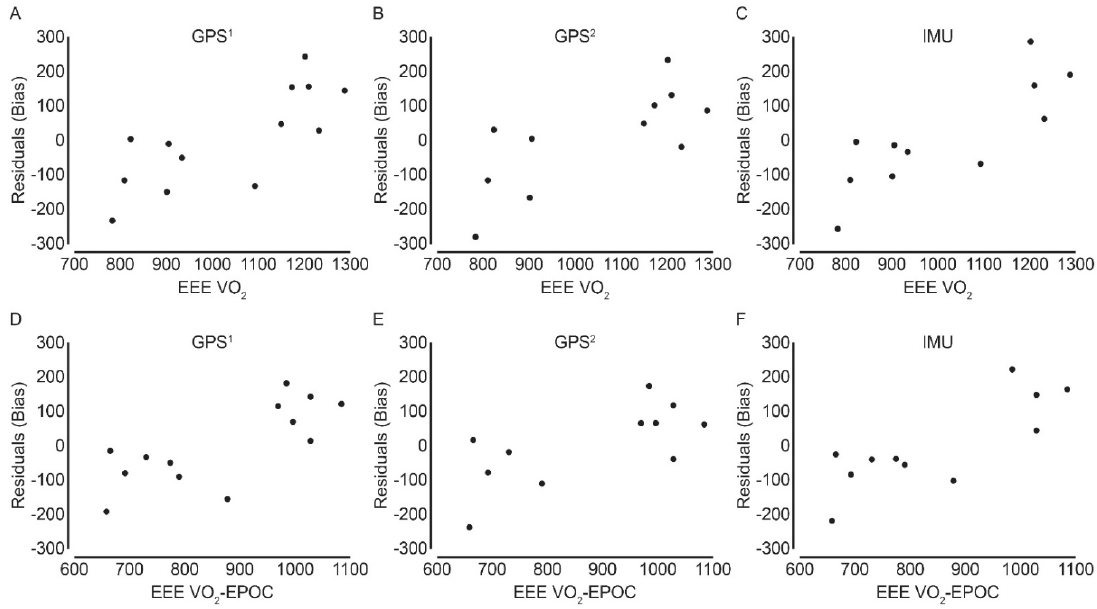
Figure 3. Residual plot indicating the disagreement between the predicted EEE (residuals) and measured EEE VO2 in the upper panel and EEE VO2 -EPOC in the bottom panel (values displayed in kJ). Negative values indicate overestimation and positive values indicate underestimation. Exercise en- ergy expenditure = EEE; kilojoules = kJ; oxygen consumption = VO 2 ; excess post-exercise energy consumption = EPOC.